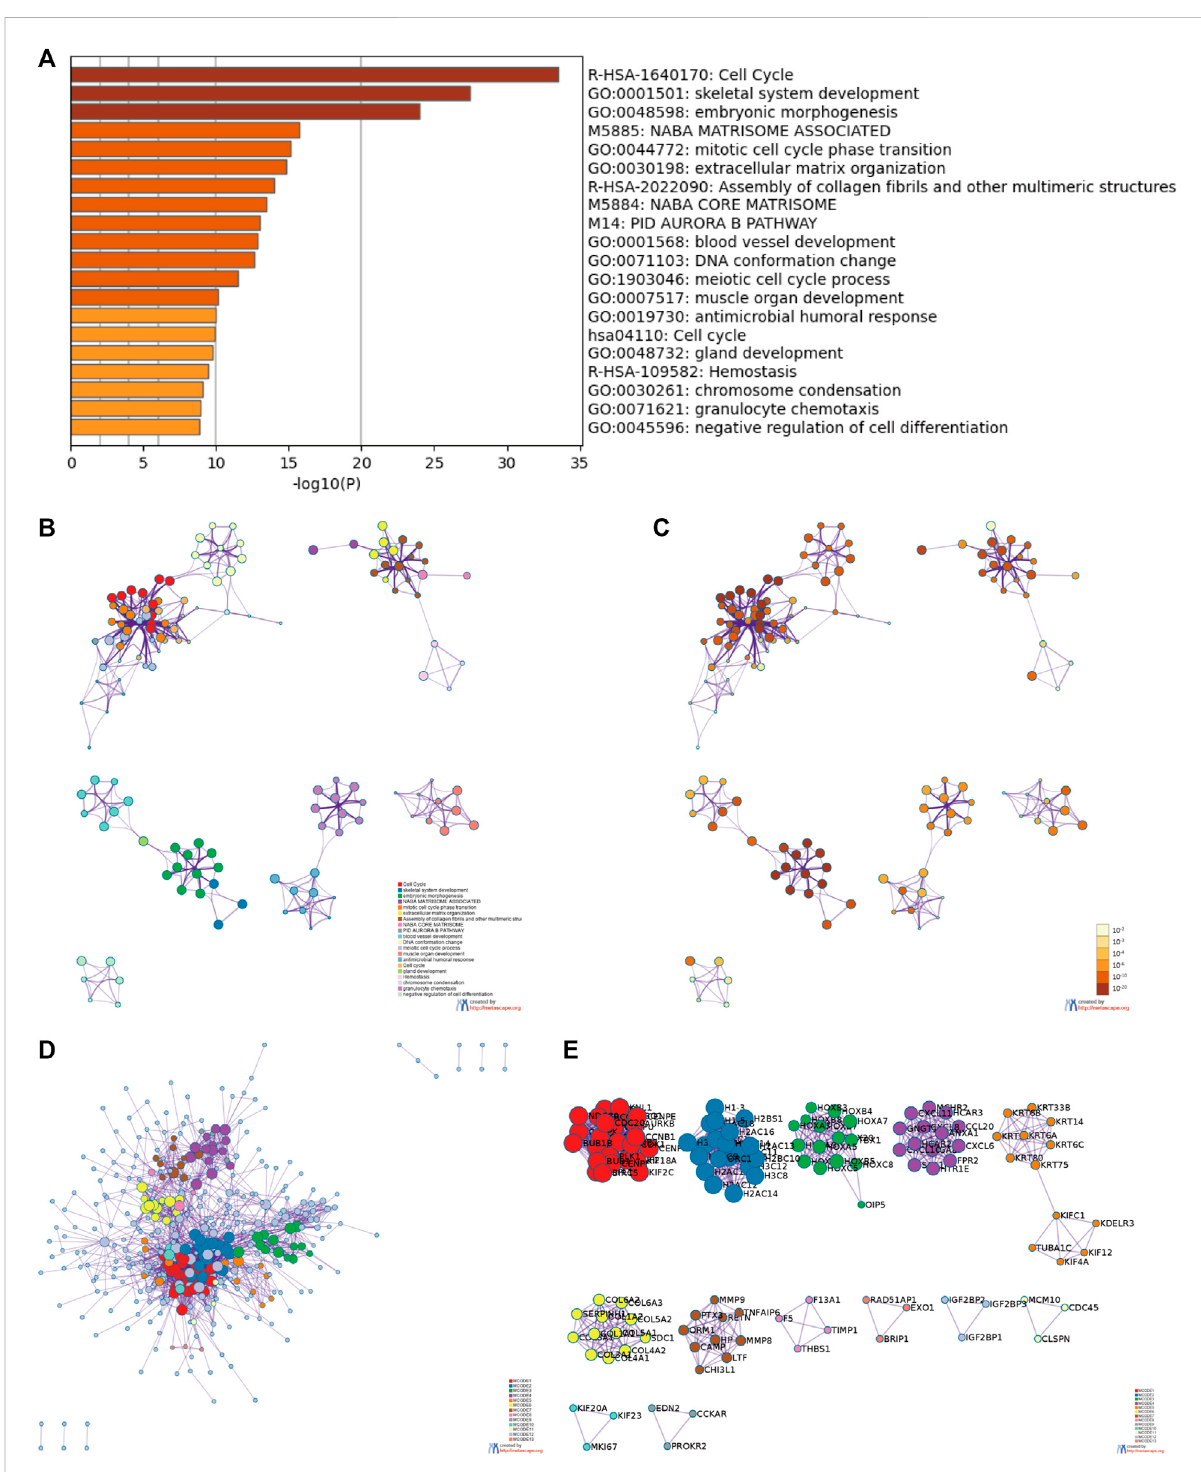
FIGURE 6 Functional enrichment and protein-protein interaction (PPI) enrichment analyses of CENP-A -related DEGs. (A) Heatmap showing Gene Ontology (GO) functional enrichment analysis. (B,C) Visualized network of top 20 GO enriched terms. (D,E) PPI networks and the most signi fi cant Molecular Complex Detection (MCODE)